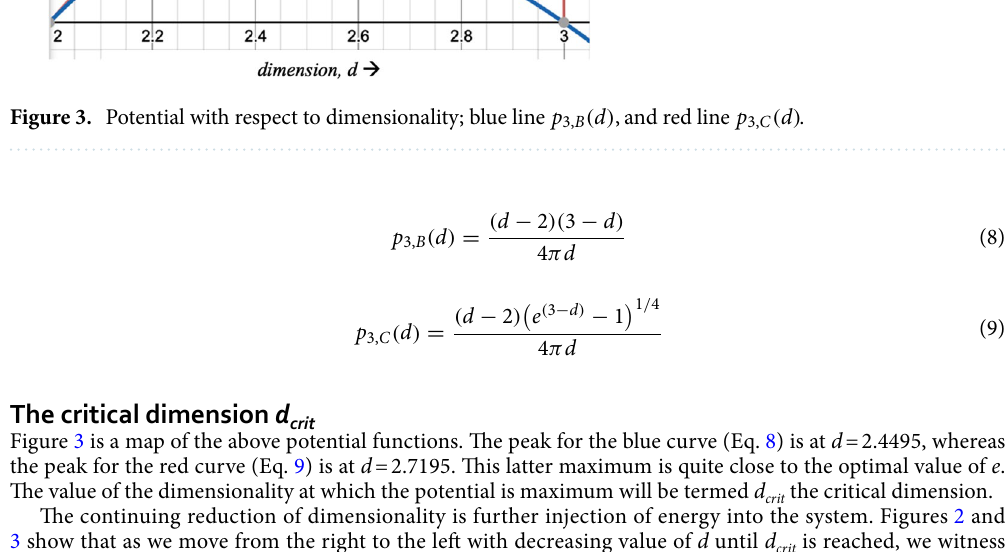
Figure 3 is a map of the above potential functions. The peak for the blue curve (Eq. 8) is at d = 2.4495, whereas the peak for the red curve (Eq. 9) is at d = 2.7195. This latter maximum is quite close to the optimal value of e .